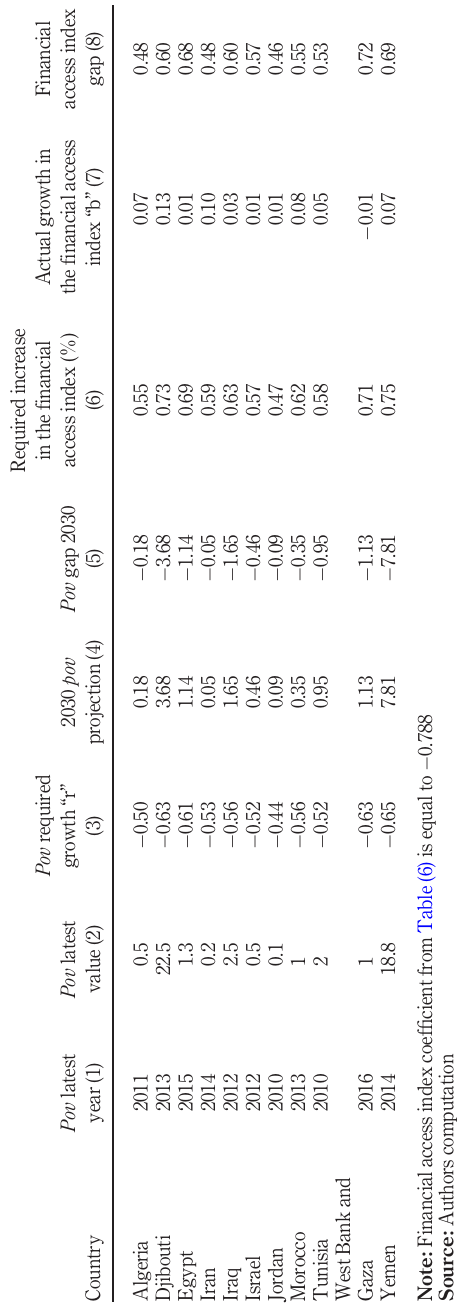
Table A7. Extreme poverty and financial access gap analysis in MENA region – assessment against the UN ’ s 0% poverty